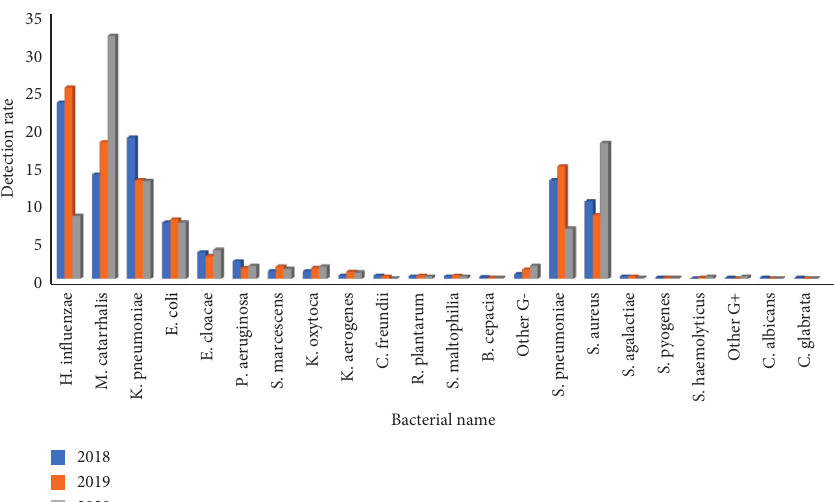
Figure 9: Detection rate of pathogens in lower respiratory tract in the third quarter before and after the pandemic situation of COVID-19 (%).